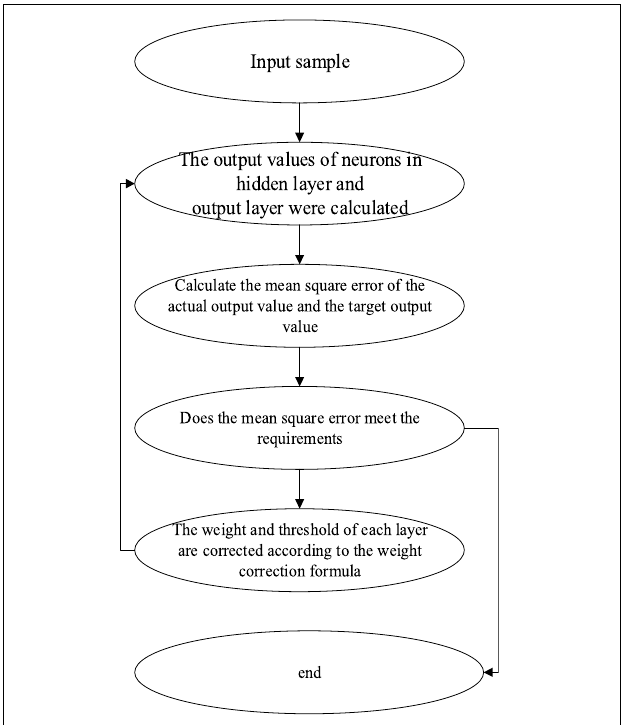
FIGURE 5 | Operation flowchart of BPNN.